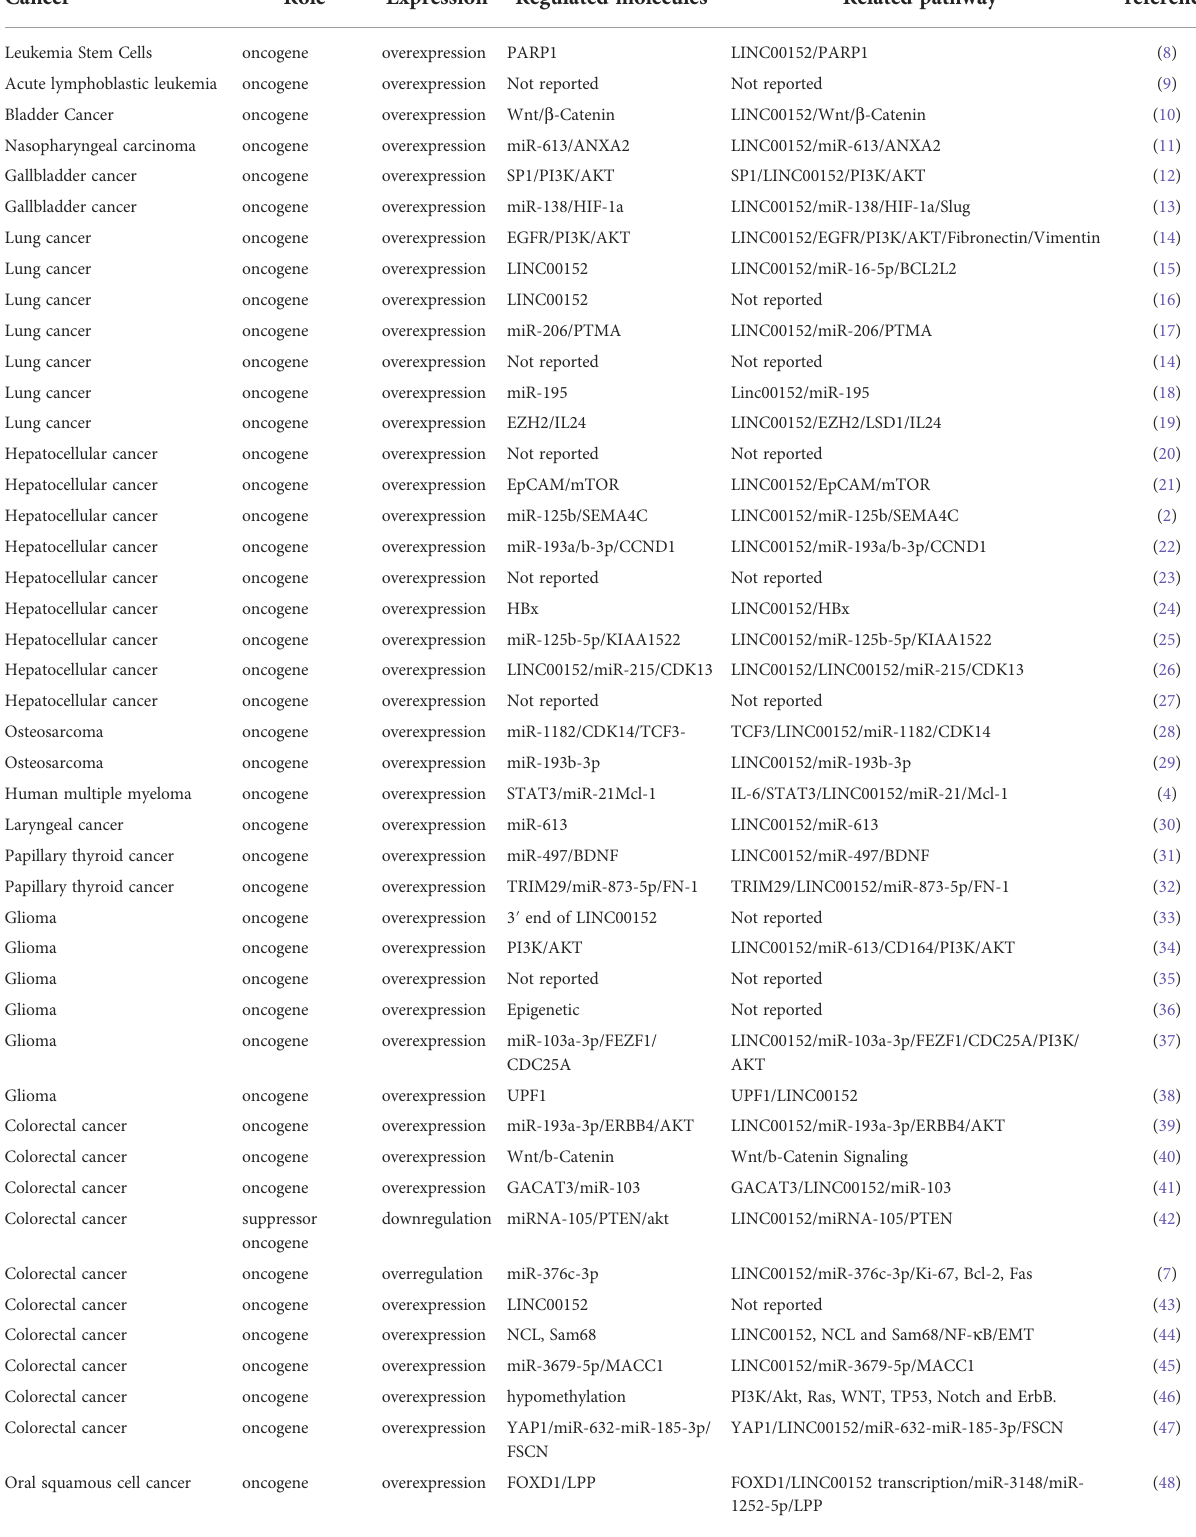
Table 1 The molecular mechanisms of LINC00152 in various cancers.